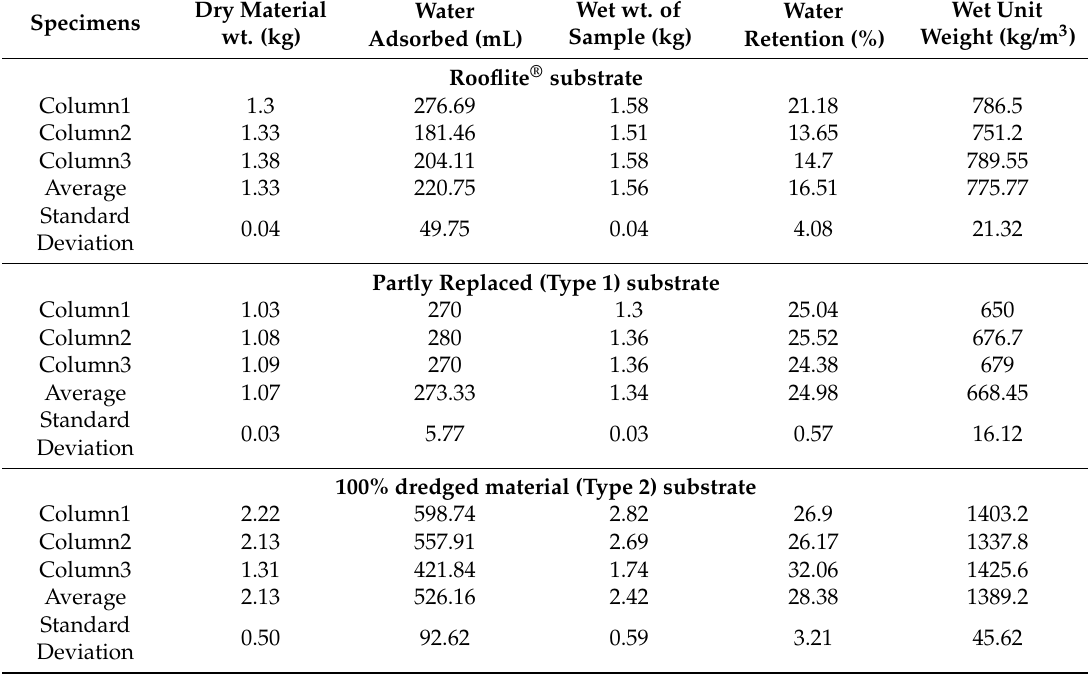
Table 2. Water retention capacity and wet unit weight of substrate (Lab Testing Results).